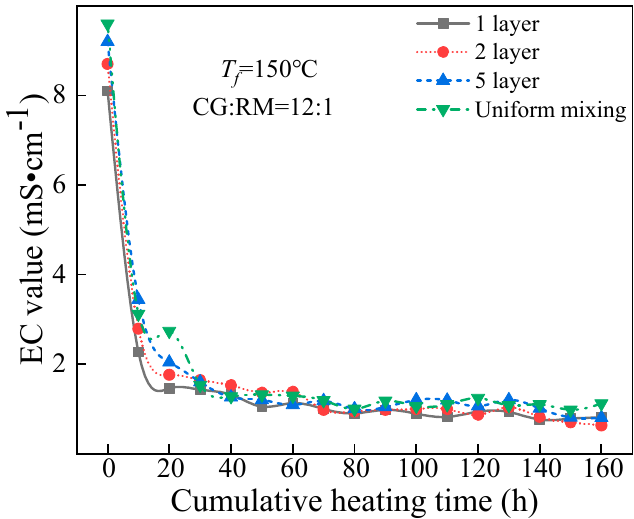
Figure 12. EC value variations of the co-disposal leaching solutions corresponding to various storage methods.